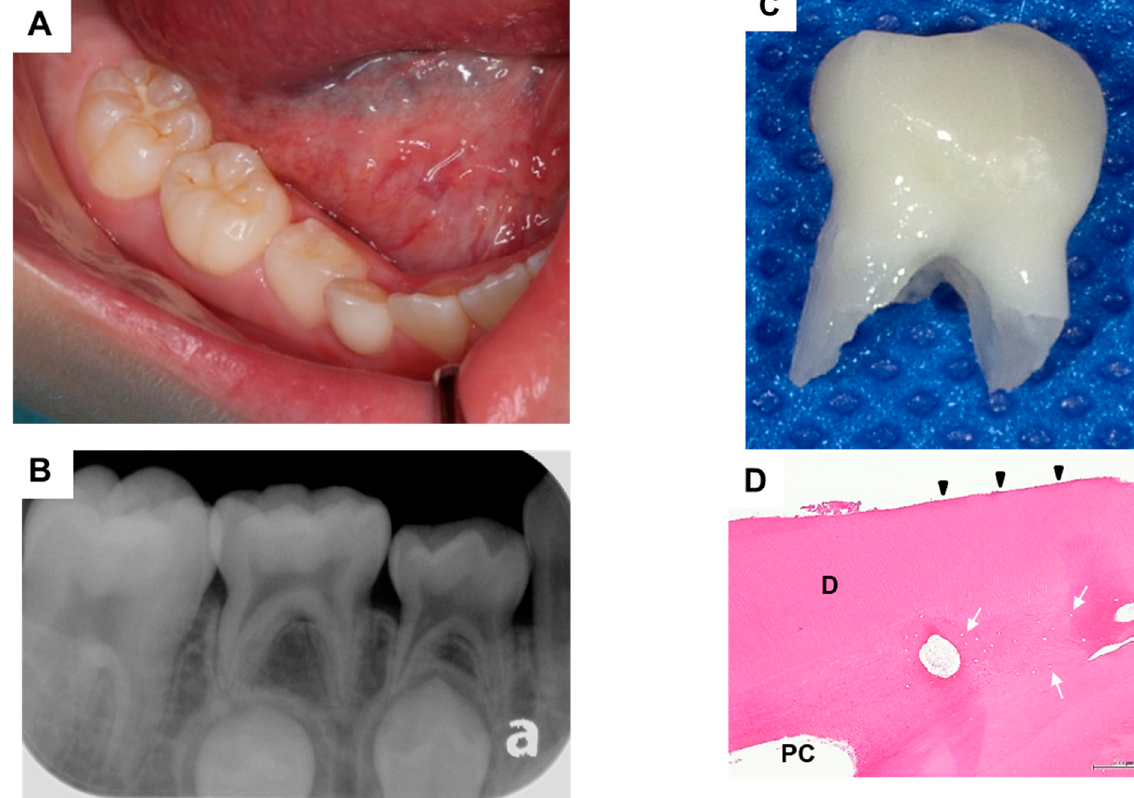
Figure 2. ( A ) Intraoral photograph taken before tooth extraction; ( B ) Dental radiograph taken before tooth extraction; ( C ) Extracted tooth; ( D ) Histopathological appearance of exfoliated molar. Disturbed cementum formation (arrowhead) and acellular cementum (arrow) are visible. D, dentin and PC, pulp chamber.